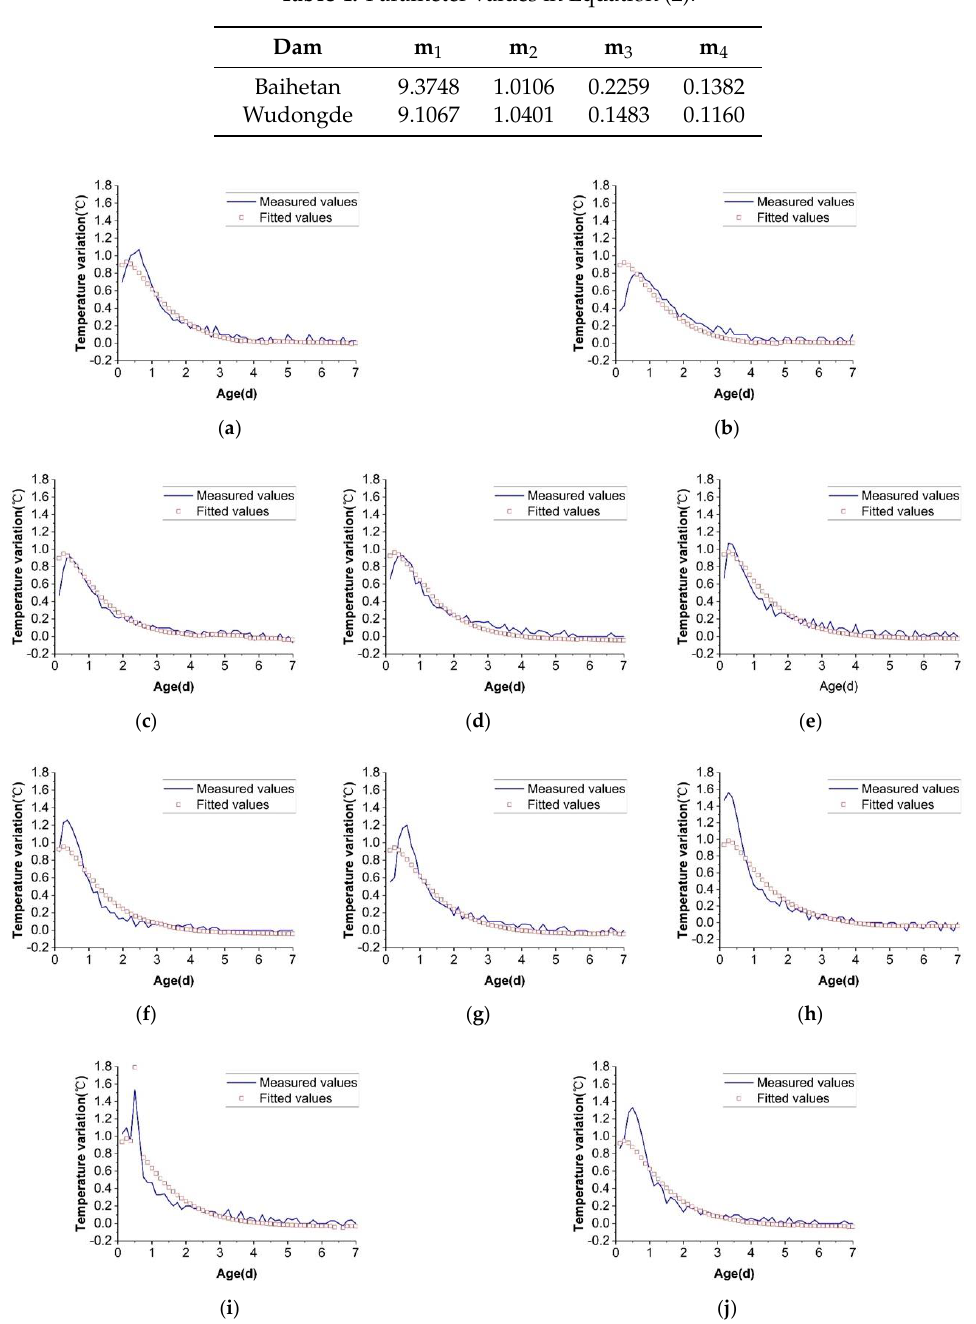
Table 4. Parameter values in Equation (2).